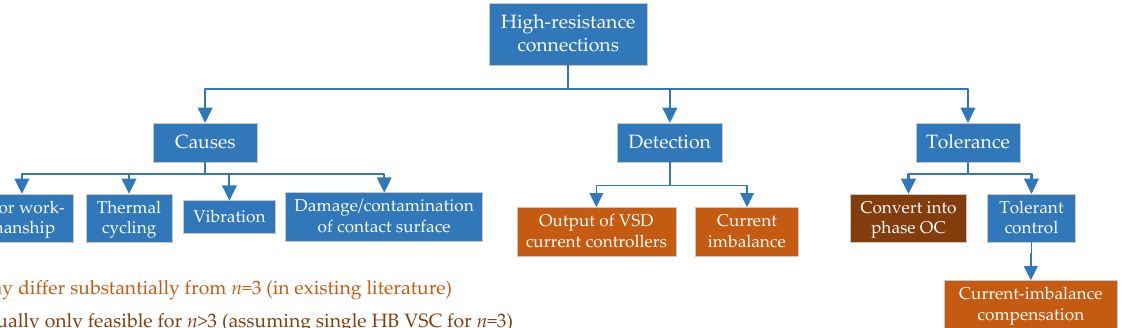
Figure 10. Causes, detection methods, and tolerance approaches for high-resistance connections in multiphase